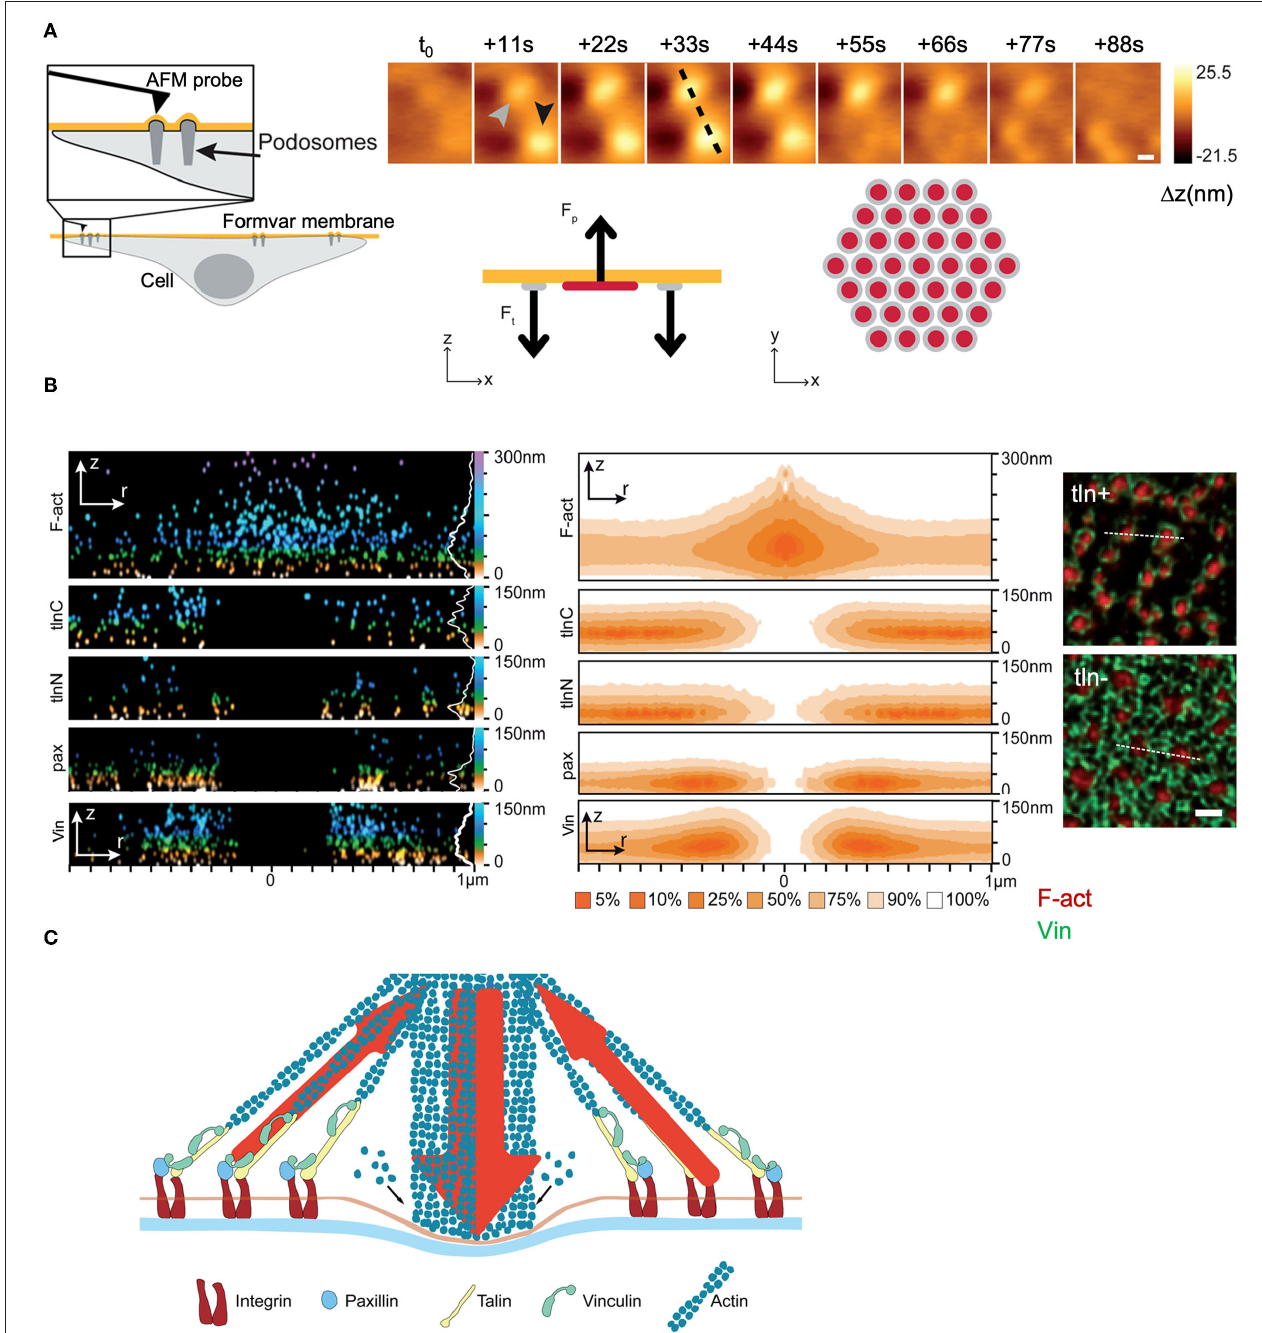
FIGURE 7 | Experimental study of the podosome structure and working mechanism. (A) AFM measurements: Topology of a pair of podosomes from fingerprint tracks left on a Formvar membrane. Simulation results: Protrusion-traction model of a single podosome in agreement with the experimental results. The stability of the podosome at a certain time is the result of a mechanical balance between protrusion forces (F p ) at the center of the podosome (red) and peripheral traction forces (F t ) (gray). (B) DONALD measurements. Spatial distribution of key structures and molecules (F-actin, talin, paxillin and vinculin) in a single podosome (left), and their corresponding probability density distributions (center). The immunofluorescence images (right) show the distribution of F-actin and vinculin in single podosomes and evince the contribution of talin in co-maintaining the annular structure. (C) Proposed general model of a podosome, featuring the molecular structure and the mechanical configuration of exerted forces. (Figures reprinted and adapted with permission from Bouissou et al., 2017). Copyright 2017 American Chemical Society.